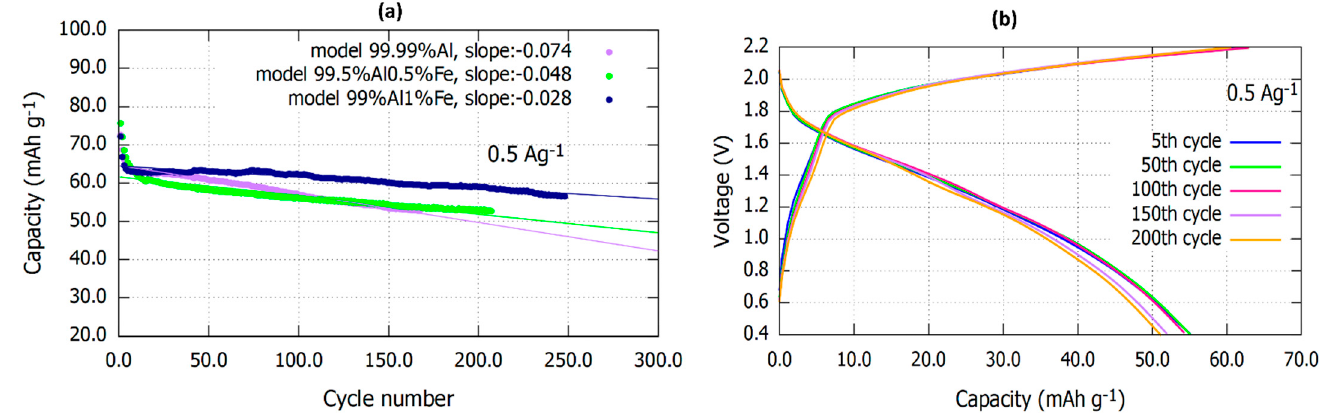
Figure 1 . Cyclic voltammetry (CV) graphs of Al-NG battery using Al alloy anodes with various Fe